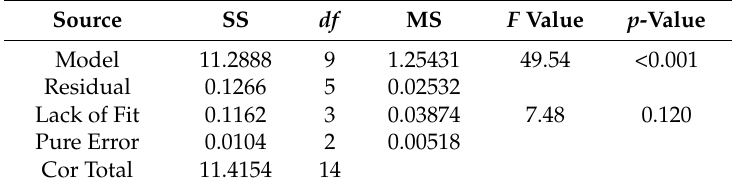
Table 3. Analysis of variance (ANOVA) for the second-order polynomial model.